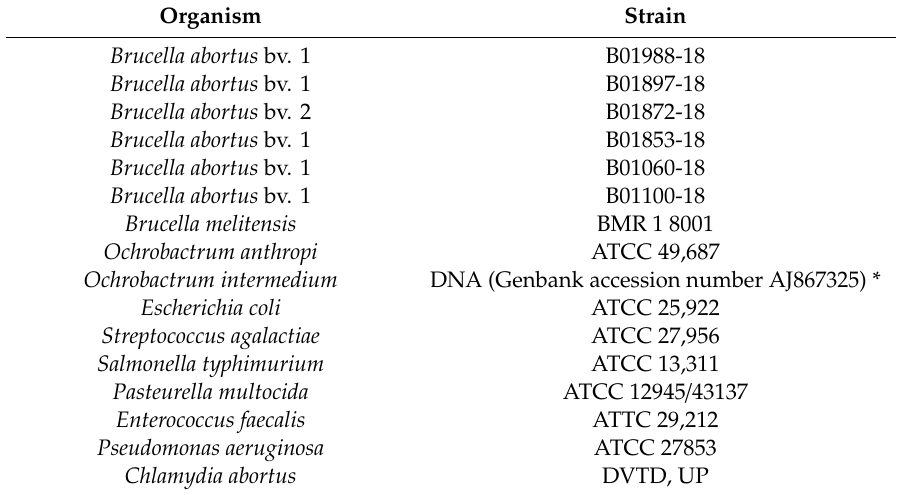
Table 1. Bacterial strains used in this